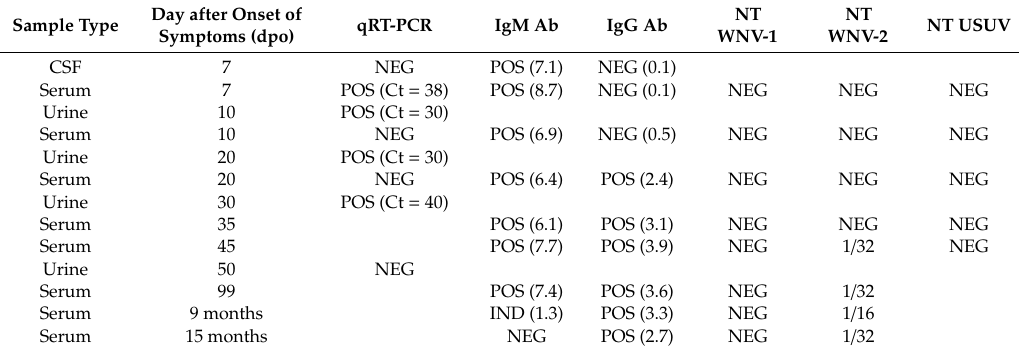
Table 1. Results obtained in the West Nile virus diagnosis. IND, indeterminate results; POS, positive; NEG, negative; IgM-Ab, IgM antibodies; IgG-Ab, IgG antibodies; NT, neutralization test; NT